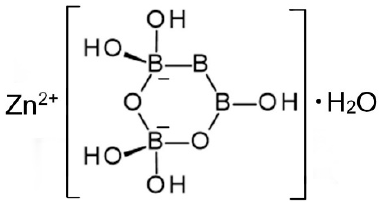
Figure 4. Schematic representation of the structure of Zn[B 3 O 3 (OH) 5 ] ∙ H 2 O [13].